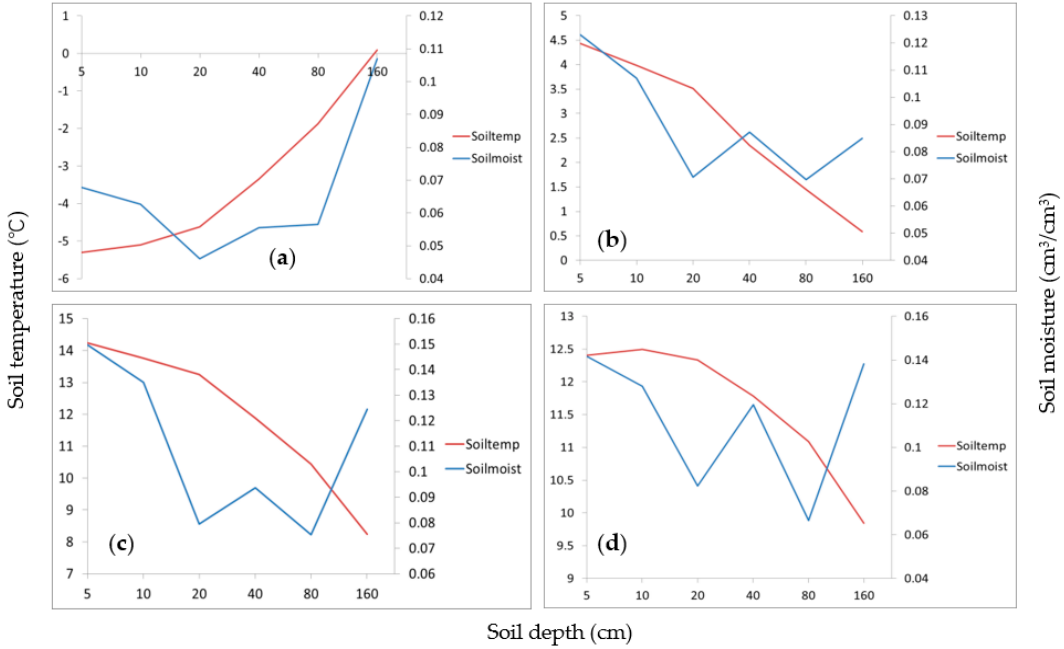
Figure 10. Same as Figure 9, but for the Nagqu station: ( a ) winter, ( b ) spring, ( c ) summer and ( d )